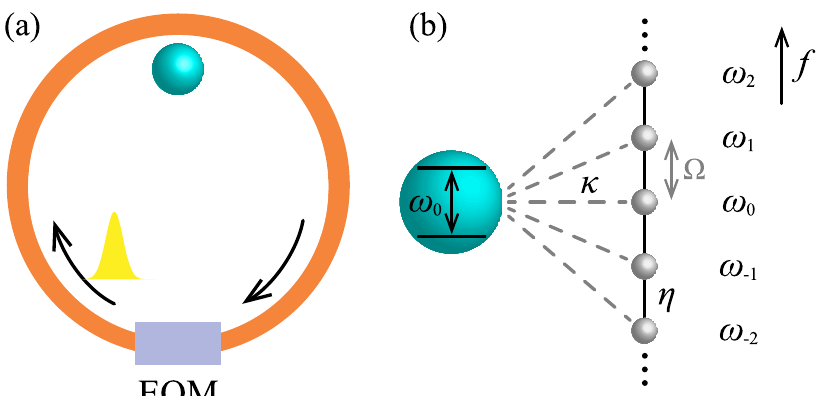
Fig. 4 Schematics for an effective giant atom coupling with a synthetic frequency waveguide. a Schematic for a dynamically-modulated ring resonator coupling to a two-level giant atom. EOM denotes to the electro-optic modulator. b The two-level atom coupled with the lattice in the synthetic frequency dimension supporting a giant atom with detuned